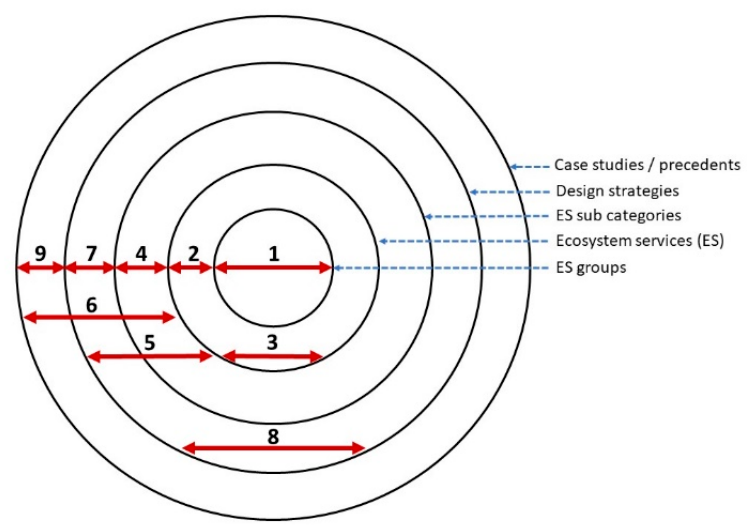
Figure 3. Schematic visualization of inner-circle, or inter-circle relationships line connections (1–9) identified between elements (ecosystem services, subcategories, design strategies, and case studies).